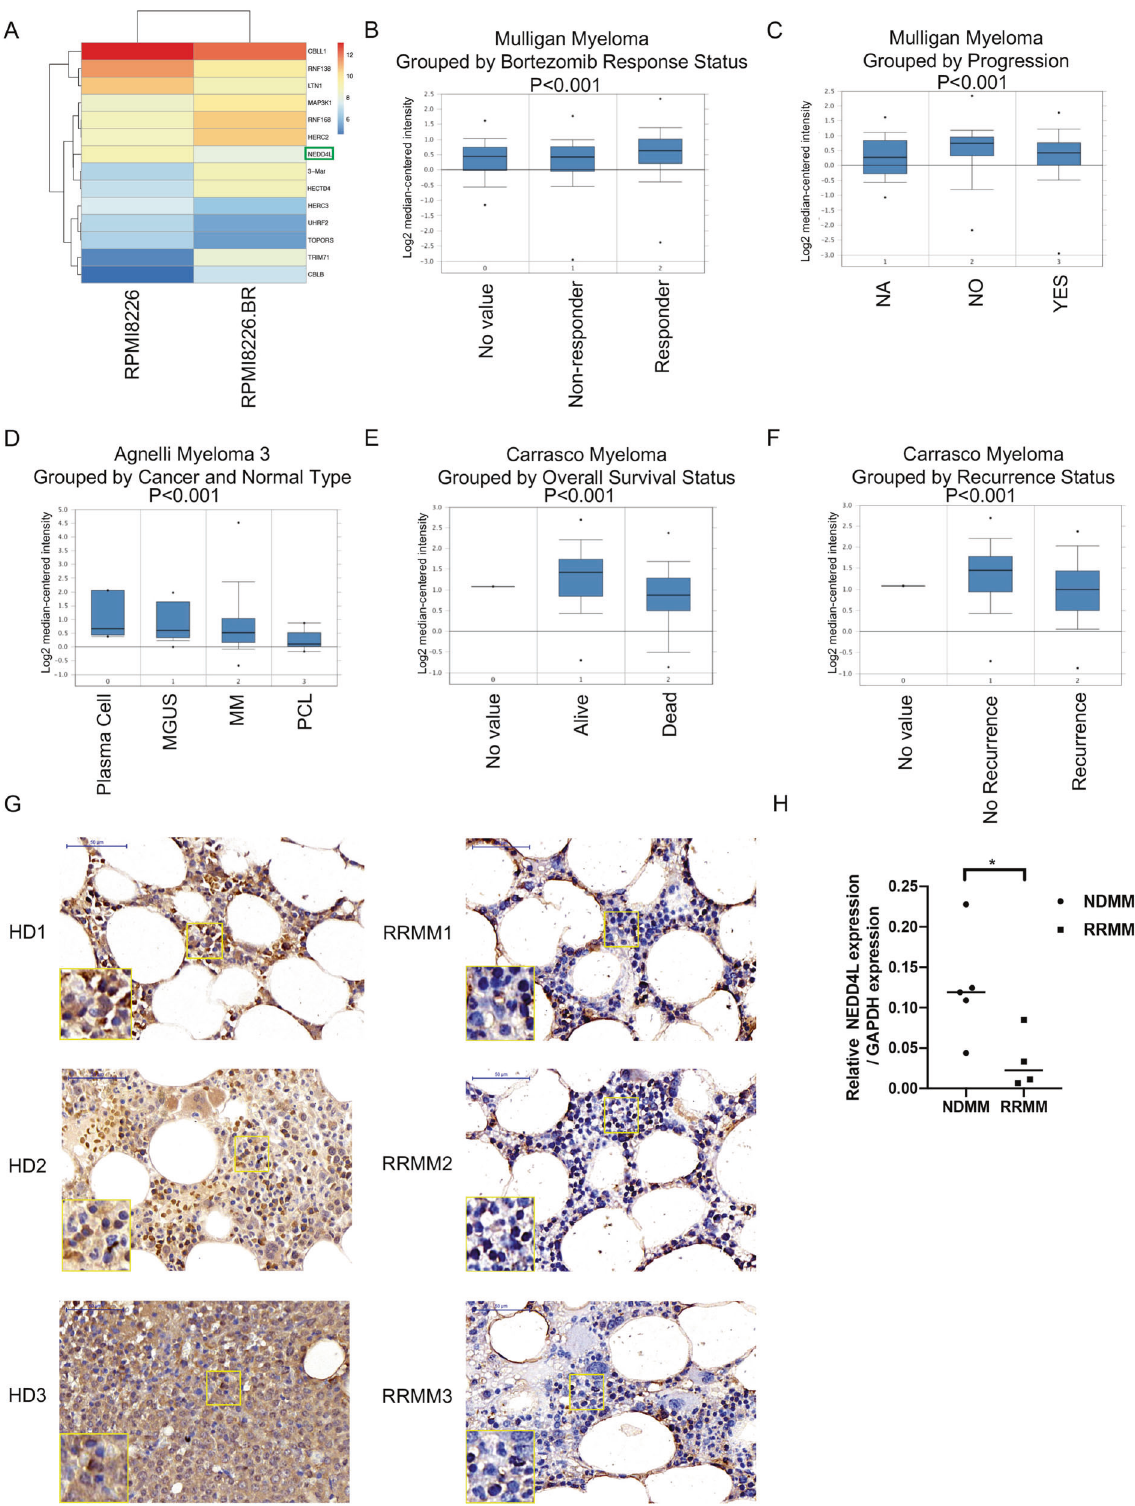
Fig. 1 Clinical signi fi cance of NEDD4L in MM. A Heatmap of the Affymetrix HTA 2.0 array in RPMI8226 and RPMI8226.BR cells showing the expression of 14 E3s. B – F Boxplots of log2 NEDD4L gene expression based on Oncomine data. NEDD4L expression in patients with different Bor responses (NR, n = 84; RES, n = 85) ( B ) and progression (NO, n = 53; YES, n = 189) ( C ). NEDD4L expression in plasma cells puri fi ed from tissues at different stages of MM and normal tissues (NPCs, n = 5; MGUS, n = 11; MM, n = 133; PCL, n = 9) ( D ). Overall survival status according to NEDD4L expression (Alive, n = 48, Dead, n = 16) ( E ). NEDD4L expression in patients without recurrence (No-R, n = 38) and with recurrence (REC, n = 26) ( F ). No value indicates patients without collected status results. G Immunohistochemical staining of NEDD4L in BM biopsies from healthy donors (HD) and relapsed/refractory MM patients (RRMM). Three representative samples are shown. Scale bars, 50 μ m. H qPCR assay of NEDD4L expression in NDMM and RRMM. Cell Death and Disease (2022)